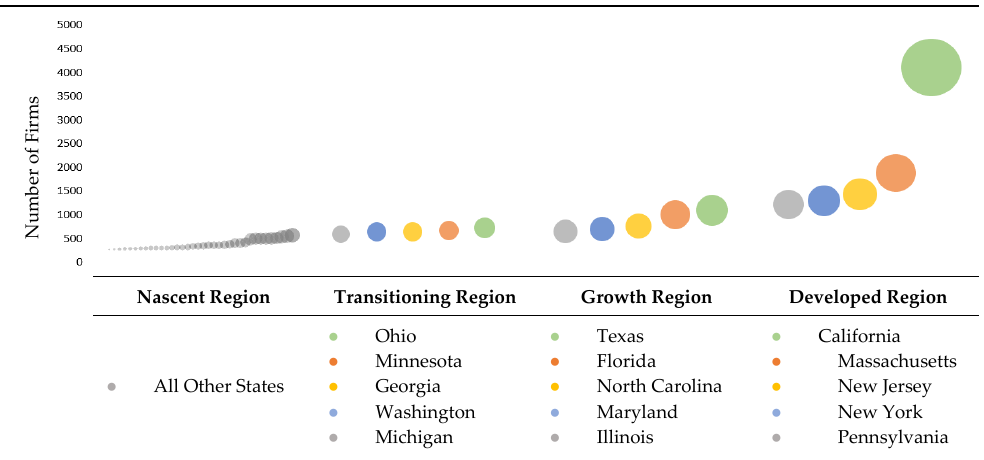
Table 2. Regional Development Composition by U.S. State.